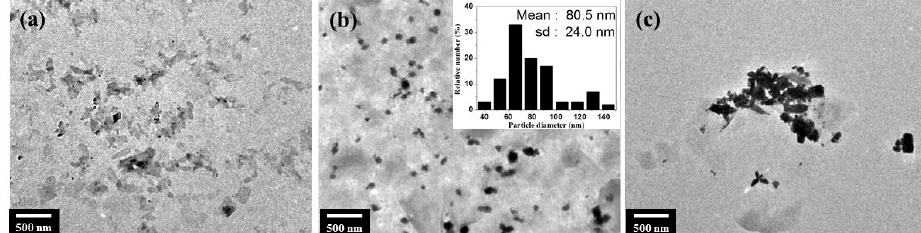
Figure 4. TEM images of ZnONP/NSP at various weight ratios. ( a ) 7/93, ( b ) 15/85 (size distribution was inserted), and ( c ) 30/70.